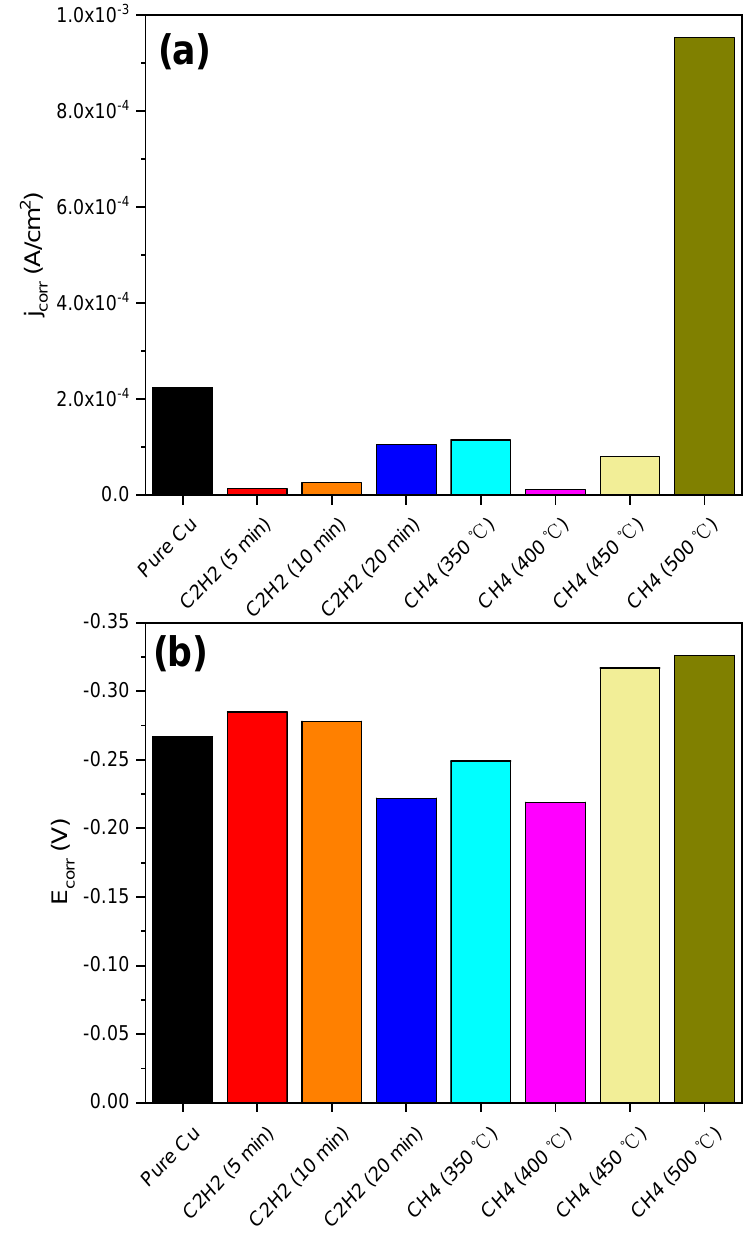
Figure 4. Summary of ( a ) j corr and ( b ) E corr of Cu and LTCVD graphene nanostructures grown on using different growth conditions (electrolyte: 3.5 wt.% NaCl solution, scan rate: 10 mV/s).